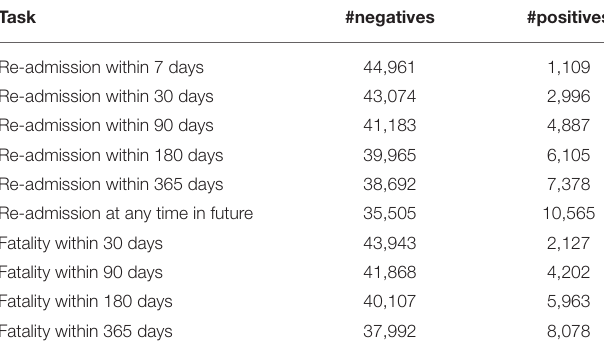
TABLE 2 | The statistics of the datasets for each prediction